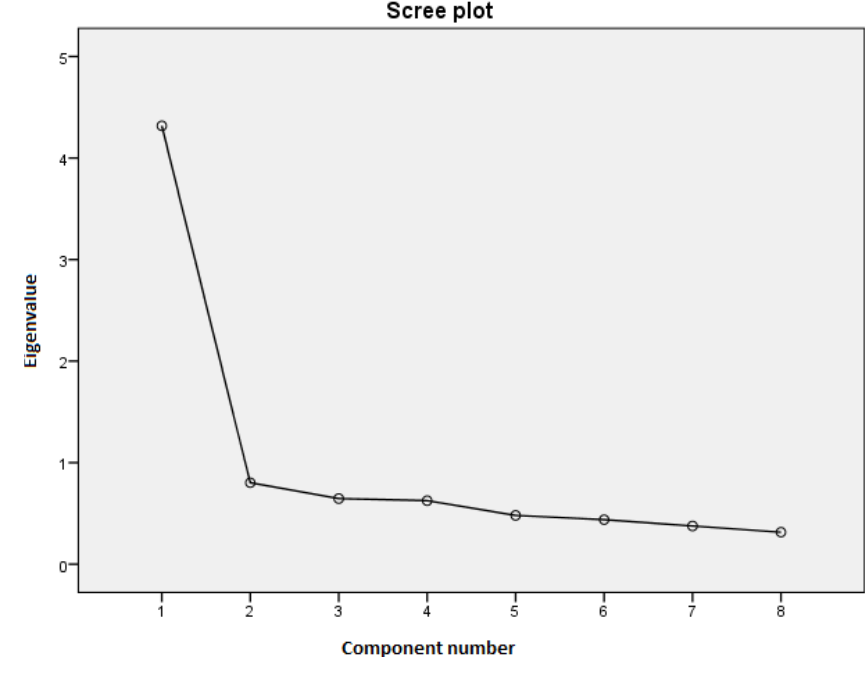
Figure 2. Scree Plot for the 8 items of the